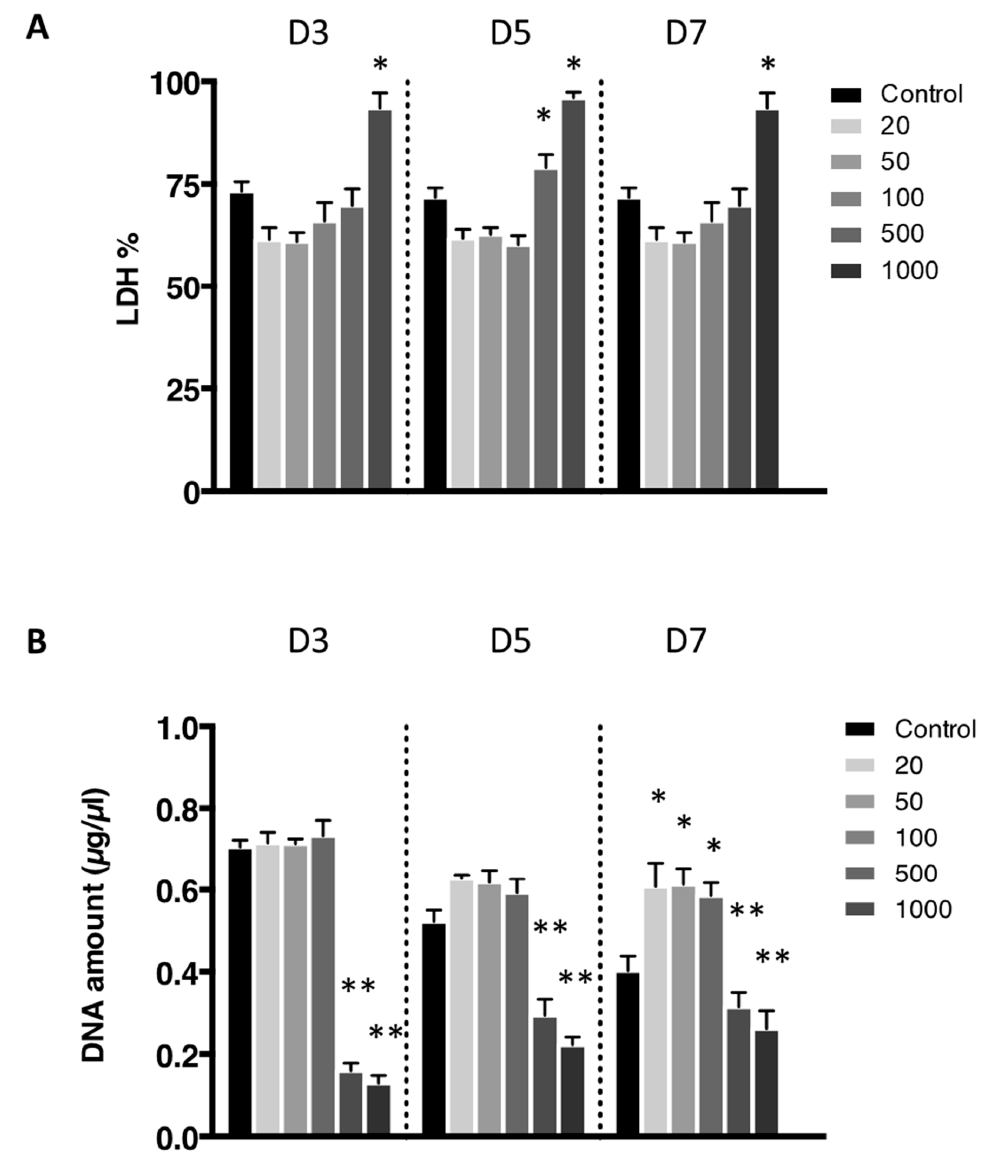
Figure 3. Lactate dehydrogenase activity of chondrocytes in contact with nanoliposomes. Rat chondrocytes were exposed to increasing concentrations of nanoliposomes (20, 50, 100, 500, and 1000 µg/mL) for 3, 5, and 7 days. ( A ) Lactate dehydrogenase (LDH) release was determined as described in Section 3; ( B ) DNA concentrations were measured to estimate cell proliferation. The results shown are mean ± SD of at least four individual experiments. * p < 0.01 and ** p < 0.001 compared to control for each time point.